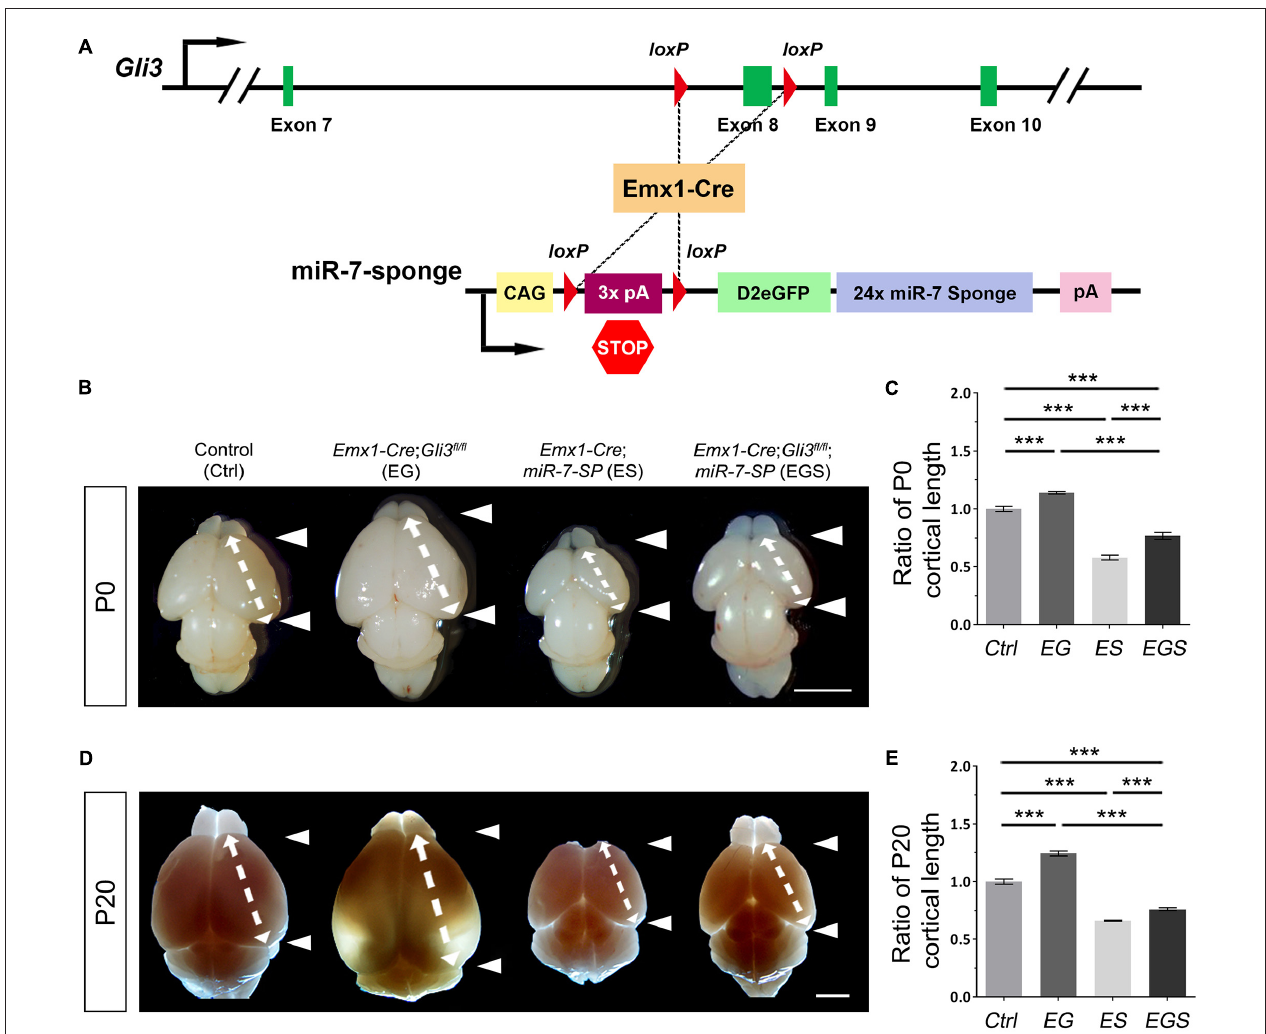
FIGURE 1 | Gli3-deficiency induces brain malformation, which is rescued by depletion of miR-7. (A) The genetic modification in Emx1-Cre ; Gli3 fl / fl ; miR-7-Sponge (EGS) mice model was induced by Emx1-Cre recombinase-dependent loss of floxed Exon8 in the Gli3 gene, and an expression of miR-7 sponge. (B–E) Cortical loss of Gli3 resulted in a notably larger and longer cortex, while the absence of miR-7 had the opposite effect of Gli3 at both P0 and P20. Values represent mean ± SEM. n > 9. ∗∗∗ P < 0.001. One-way ANOVA with post hoc test was used. Scale bar = 5